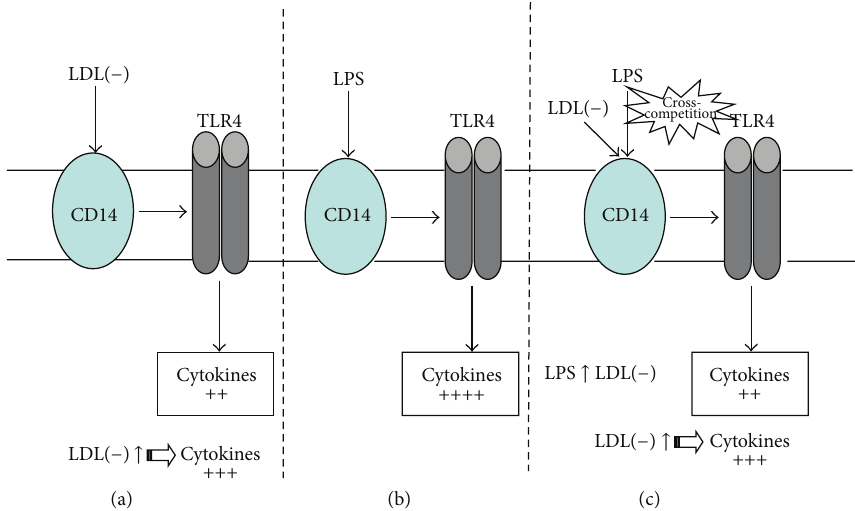
Figure 4: Cytokine induction through CD14-TLR4 by LPS and LDL( − ). In the absence of bacterial infection, CD14-TLR4 activation mediated through LDL( − ) triggers an inflammatory response that would be deleterious in case of high LDL( − ) concentration (a). This effect would be lower than that induced by LPS at high concentrations (infection) in the absence of LDL( − ) (b). When LPS and LDL( − ) coexist, there is a competition between the two stimuli. The global effect will depend on the relative concentration of both molecules (c). TLR4: toll-like receptor 4, LPS: lipopolysaccharide, LDL( − ): electronegative